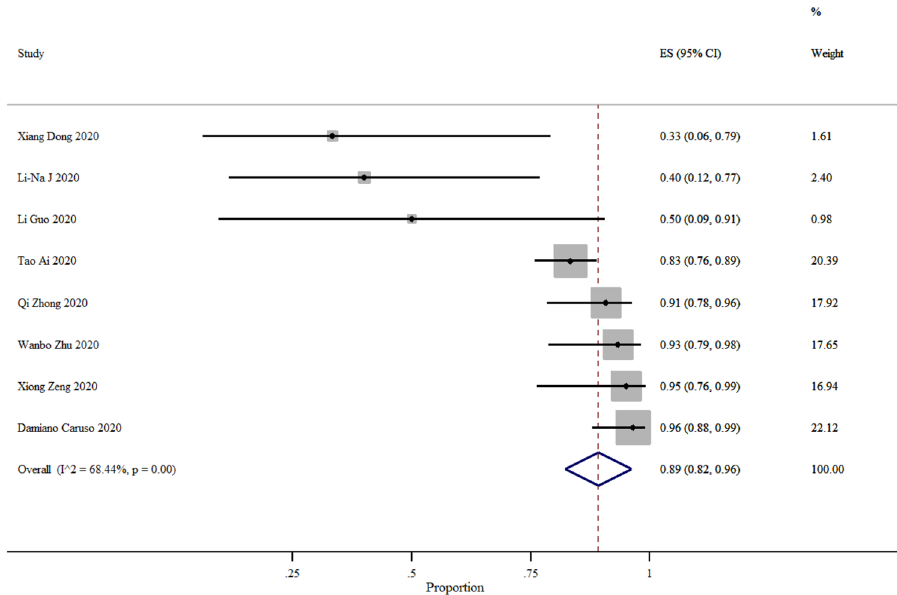
Figure 6. Summary of negative predictive value and 95% CI of six studies, generated by the